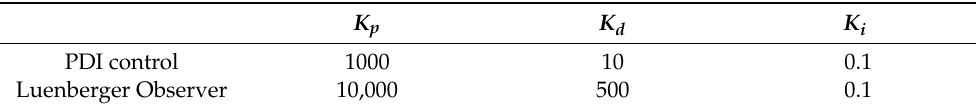
Table 5. Observer and controller gains 1 .